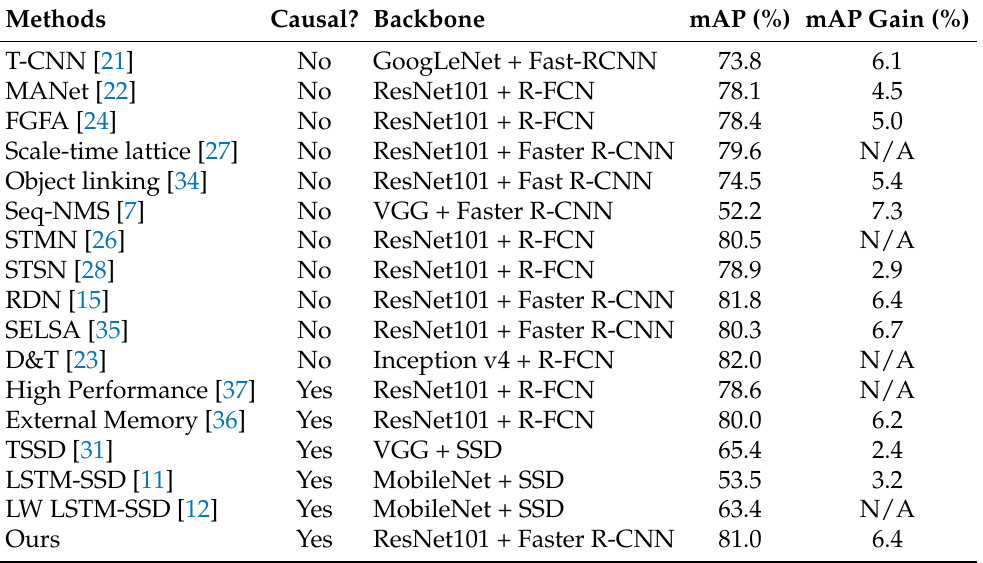
Table 7. Performance comparison with other state-of-the-art methods using ImageNet VID validation